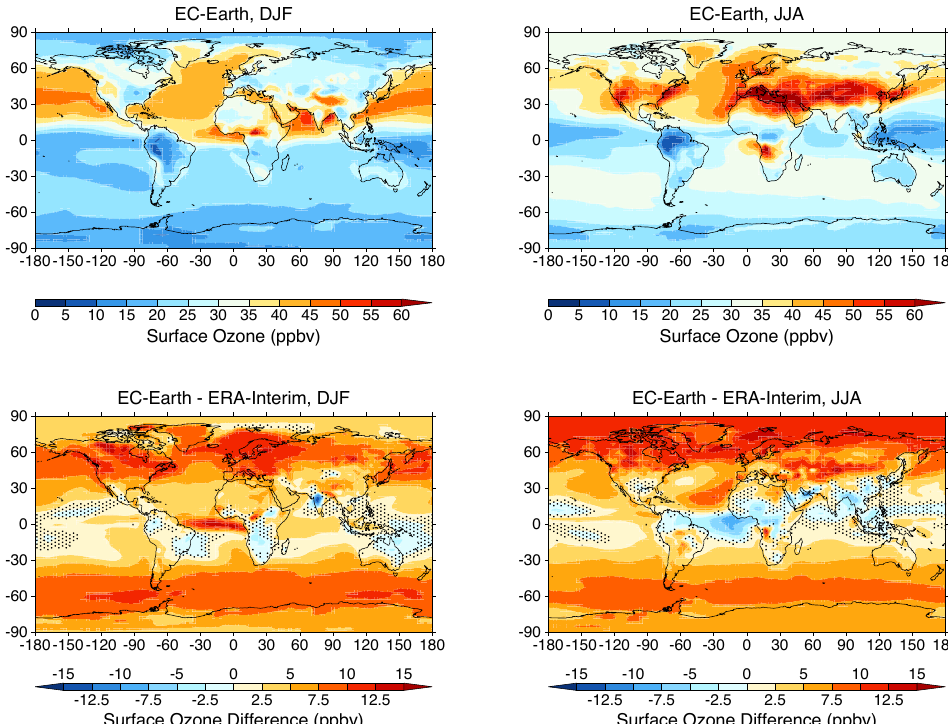
Figure 10. Surface O 3 mixing ratios in the reference EC-Earth simulation (top) and the differences compared to the corresponding ERA- Interim simulation (bottom) for boreal winter (left) and boreal summer